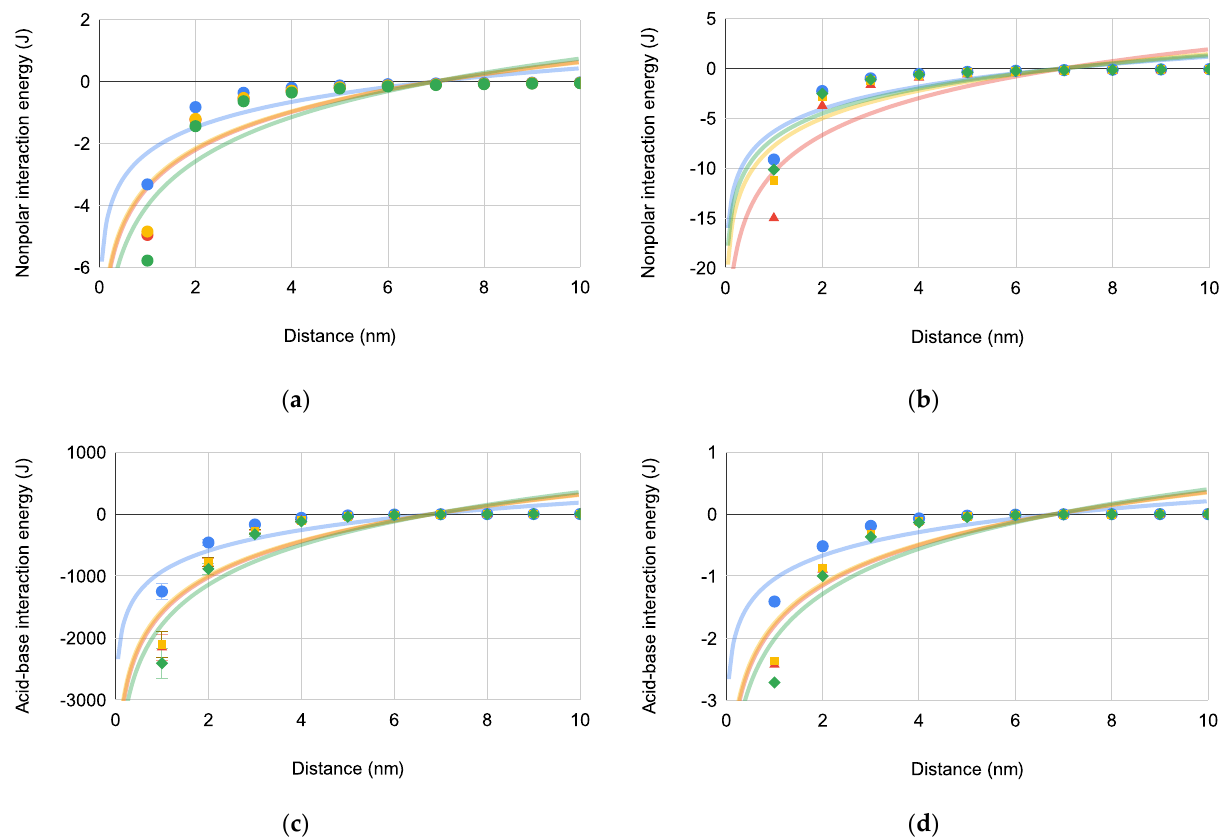
Figure 3. Bacteria-substrate Gibbs interaction energies [PA (blue circles), EC (green diamonds), SA (red triangles), and SE (orange squares)] versus distance for bacterial interactions: ( a ) 𝛥𝐺 132𝐿𝑊 (× 10 −21 ) where 𝑑 𝑒𝑞 = 7.02 ± 0.00479 𝑛𝑚 ( N = 4), ( b ) 𝛥𝐺 13𝐿𝑊 (× 10 −21 ) where 𝑑 𝑒𝑞 = 7.02 ± 0.0149 𝑛𝑚 ( N = 4), ( c ) 𝛥𝐺 132𝐴𝐵 (× 10 −8 ) where 𝑑 𝑒𝑞 = 6.83 ± 0.00854 𝑛𝑚 ( N = 4) and ( d ) 𝛥𝐺 13𝐴𝐵 (× 10 −8 ) where 𝑑 𝑒𝑞 = 6.81 ± 0.0193 𝑛𝑚 ( N = 4).